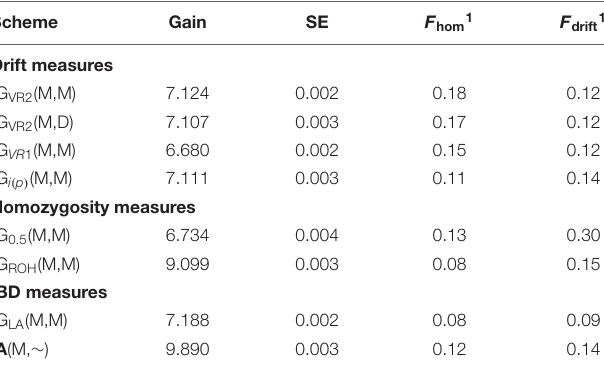
TABLE 3 | Genetic gain (and its SE) after 20 generations of selection expressed in initial genetic standard deviation units, and inbreeding measured by homozygosity for Panel N of neutral loci at generation 20 for